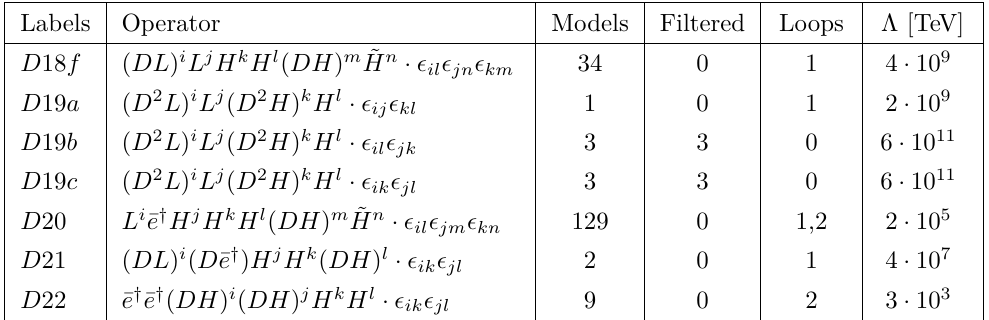
Table 8 : The table displays our listing of the ∆ L = 2 operators along with the number of comple- tions before and after our model-filtering procedure, the number of loops in the neutrino self-energy diagram, and the upper bound on the new-physics scale associated with each operator. See the main text of the appendix for more